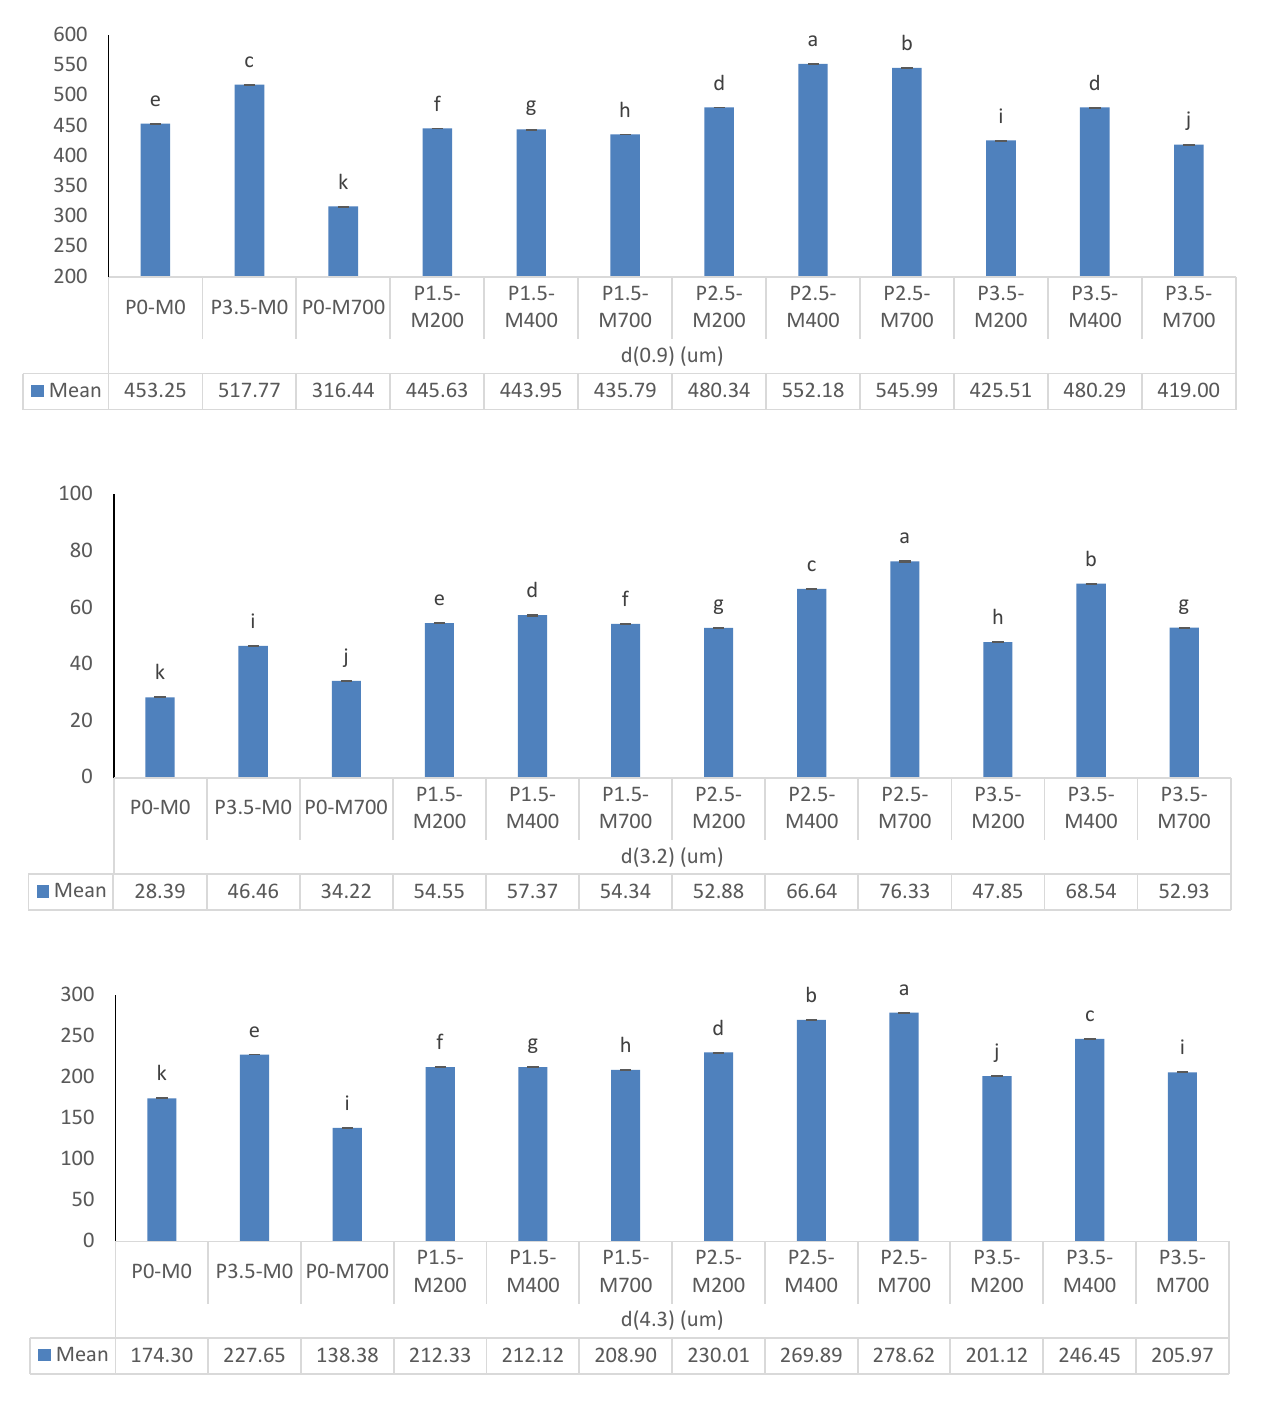
Figure 7. The effect of phosphorylation (%) and microwave power (W) on particle size distribution of egg white powder. Means ( n = 3) with different letters in each column indicate significant difference ( p < 0.05).